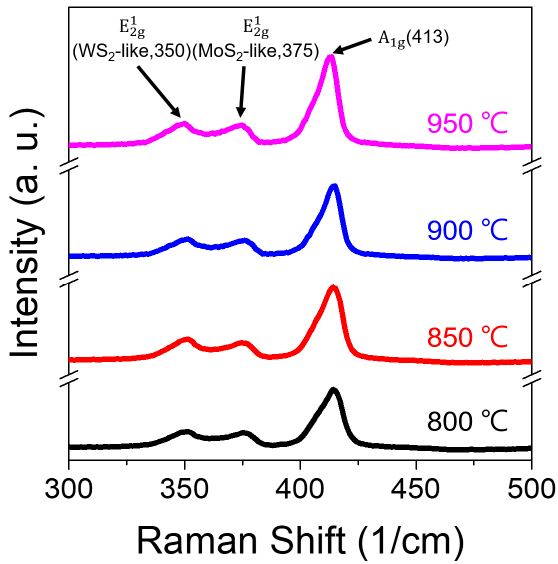
Figure 1. Raman spectra of the Mo x W 1 − x S 2 thin films by sulfurizing MoW alloy at different temperatures from 800 to 950 °C.